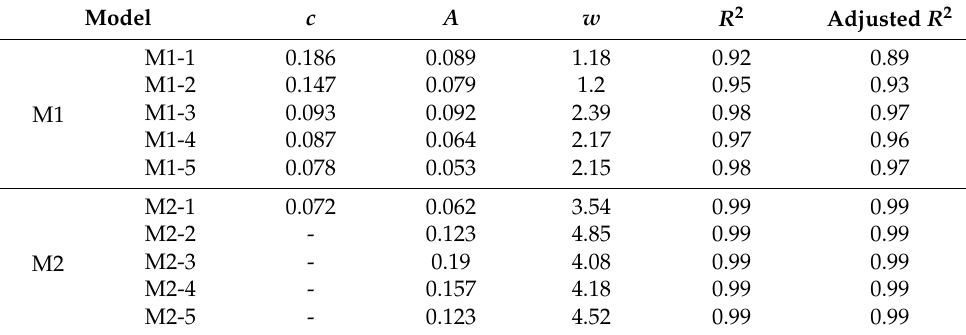
Table 8. Parameter values of curve model.